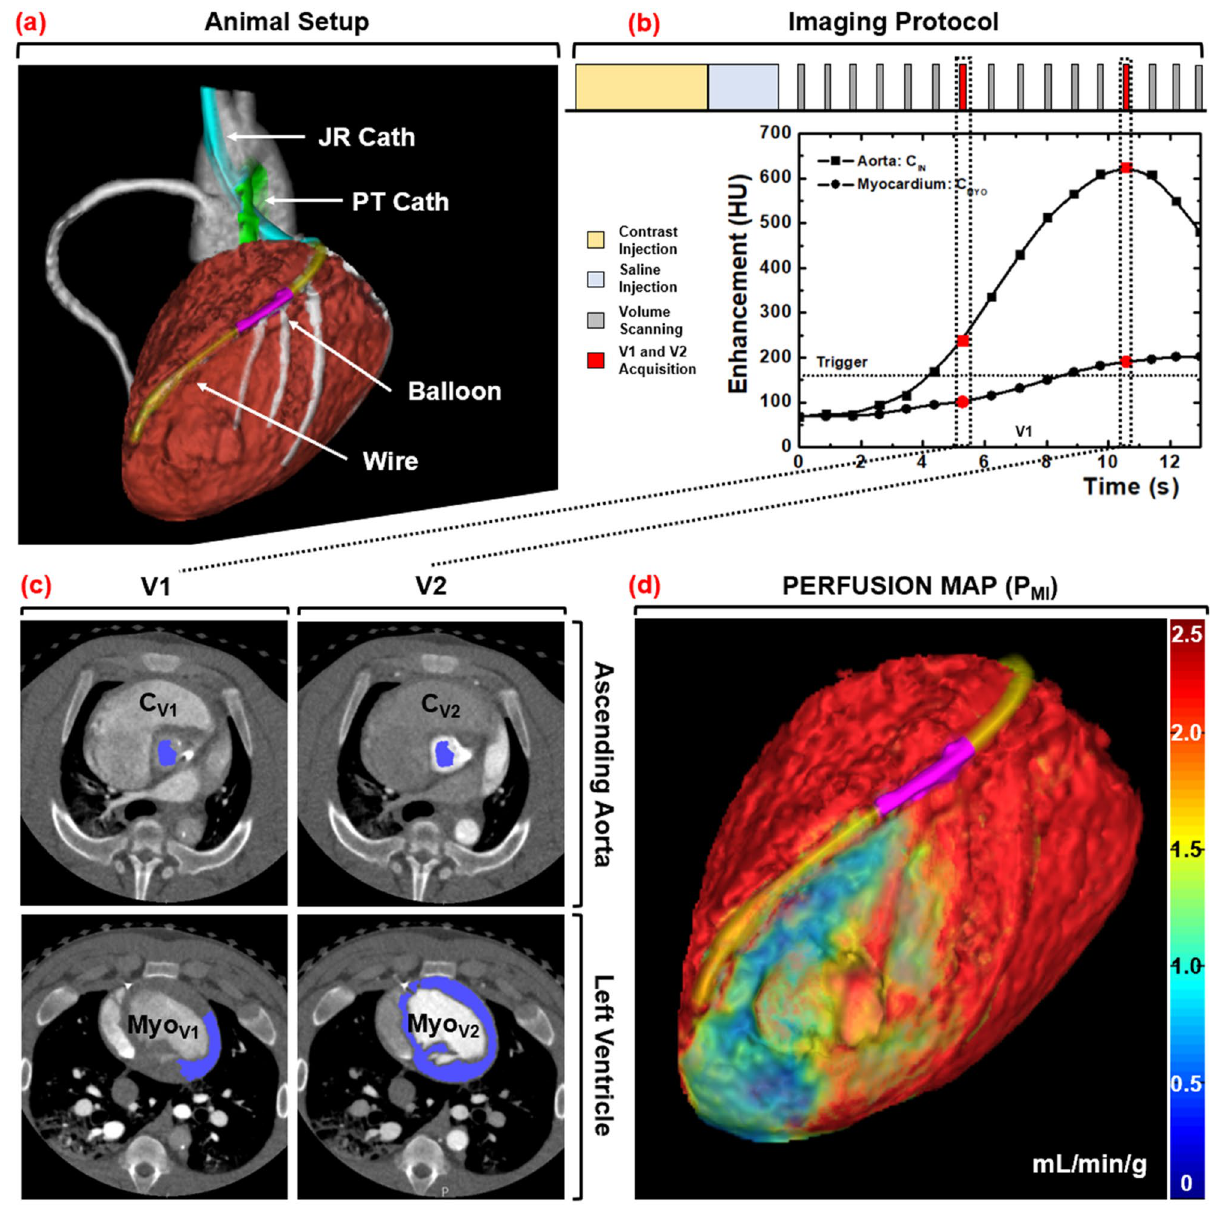
Figure 1. Animal setup, imaging protocol, and image processing scheme. ( a ) Interventional setup displaying the Judkins Right (JR) and Pigtail (PT) catheters, coronary balloon, and pressure wire. ( b ) Dynamic CT imaging protocol, with V1 and V2 denoted in red. ( c ) Semi-automatic segmentation of the aortic blood pool and myocardium. ( d ) MI perfusion map derivation with a distal LAD defect